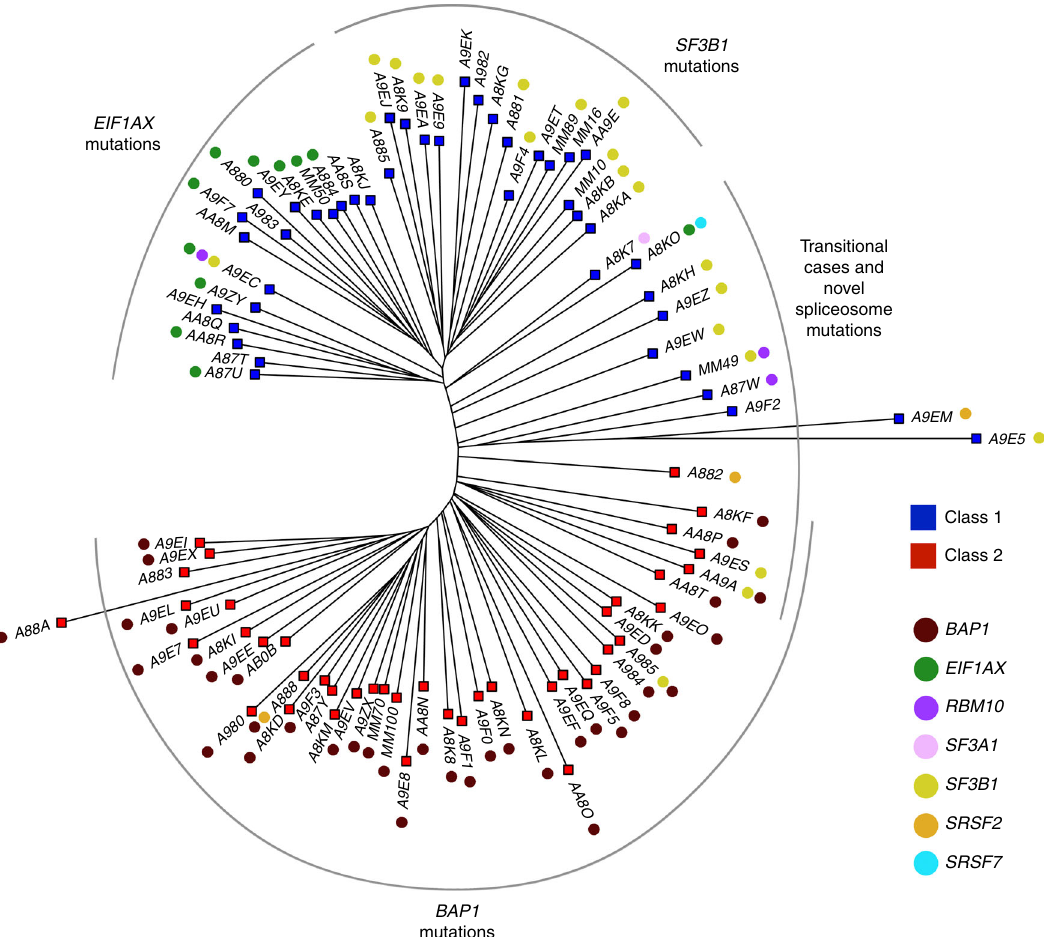
Fig. 3 Phylogenetic tree demonstrating relationships between uveal melanoma samples based on genomic DNA methylation. A minimum evolution algorithm (Canberra distance) was used to build an unrooted evolutionary tree. Gene expression pro fi le (class 1 versus class 2) and mutation status are indicated. These data are presented in a rooted phylogenetic tree with signi fi cance estimates in Supplementary Fig.